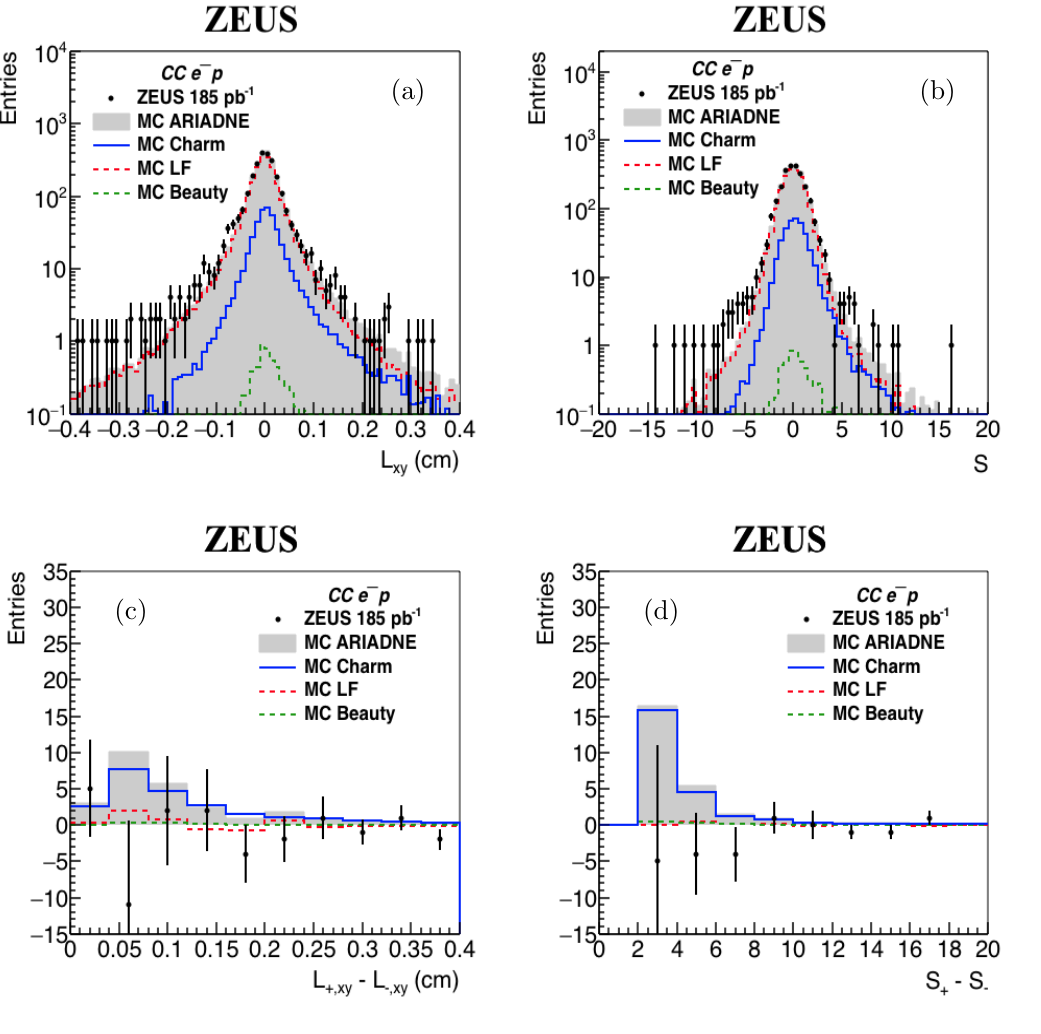
Figure 8. Comparison between data (points with vertical error bars) and MC (histogram) for e + p collisions for distributions of (a) the 2D decay length L xy and (b) signi(cid:12)cance S distribution and for distributions of the subtracted (c) decay-length L + xy (cid:0) L (cid:0) xy and (d) signi(cid:12)cance S + (cid:0) S (cid:0) distribution. The labels are the same as in (cid:12)gures 3 and 4. \MC beauty" represents events with beauty but no charm